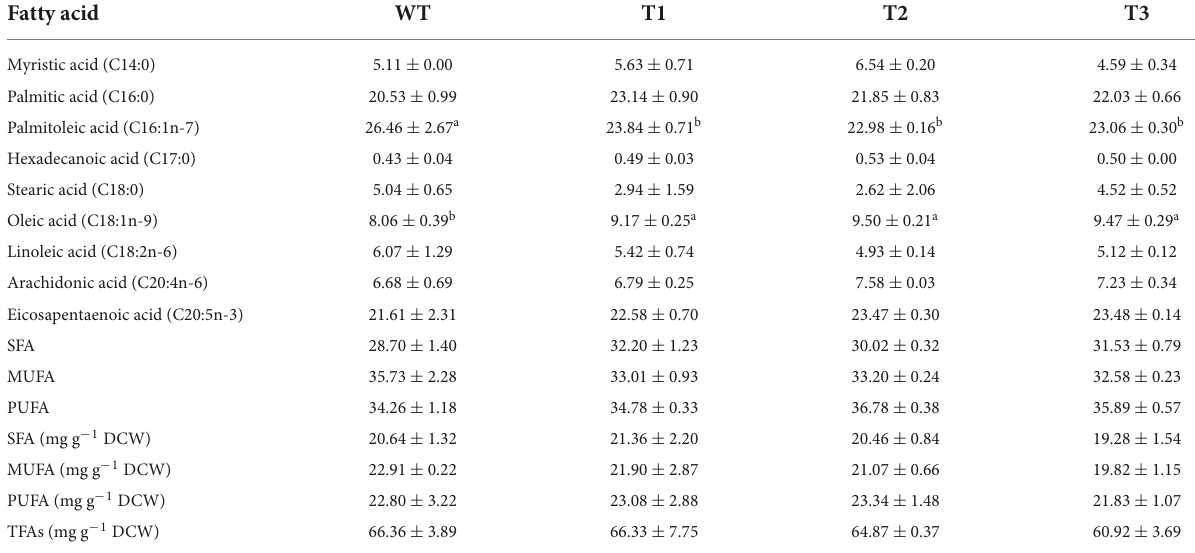
TABLE 3 Fatty acids analysis of WT and